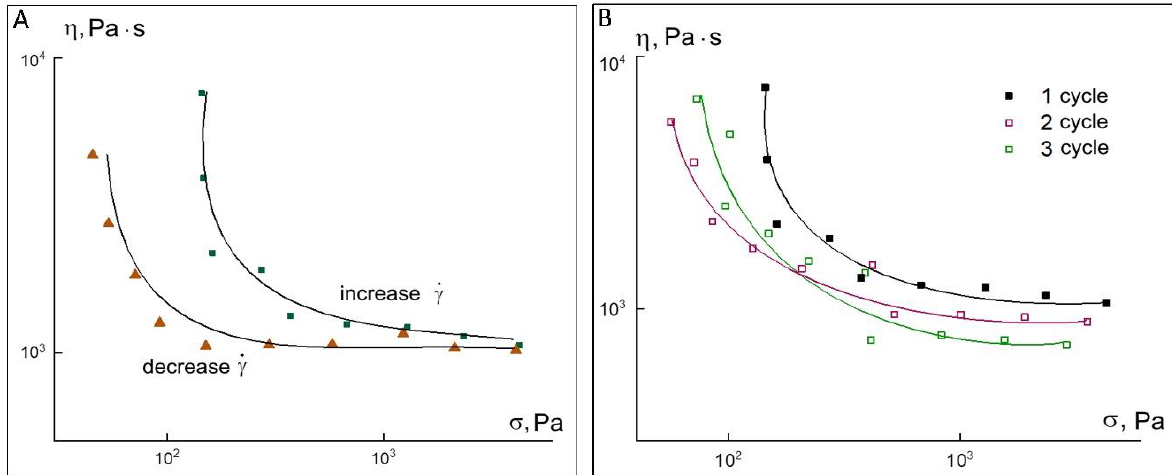
Figure 7. Dependences of polylactide viscosity on shear stress in shear rate increasing and decreasing mode ( A ). Results of repeated measurements of the flow curve of structured polylactide melt at cyclic increase and decrease in shear rate (for clarity, the curves are shown only in the shear rate increase mode) ( B ).